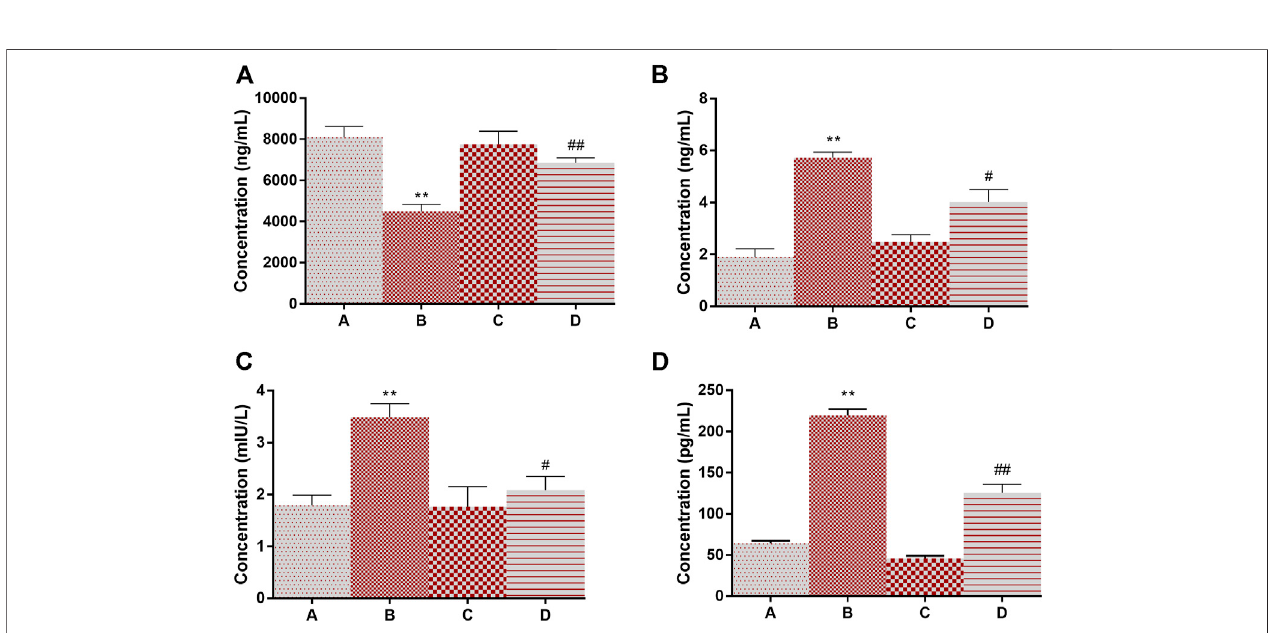
FIGURE5| Modulationoflevelsofadiponectin,leptin,insulin,andIL6inresponseto4-(methylthio)butylisothiocyanateandDMBA. (A) Adiponectin, (B) Leptin, (C) Insulin, (D) IL-6. ** p < 0.01 when compared with group A and # p < 0.05, ## p < 0.01 when compared with group B.